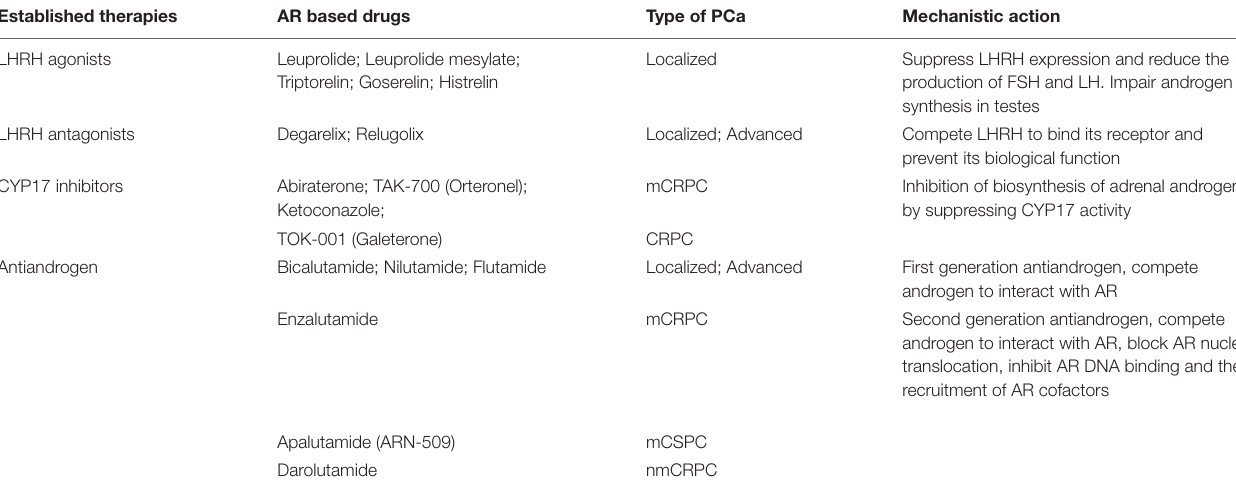
TABLE 1 | Androgen receptor targeted therapies in prostate